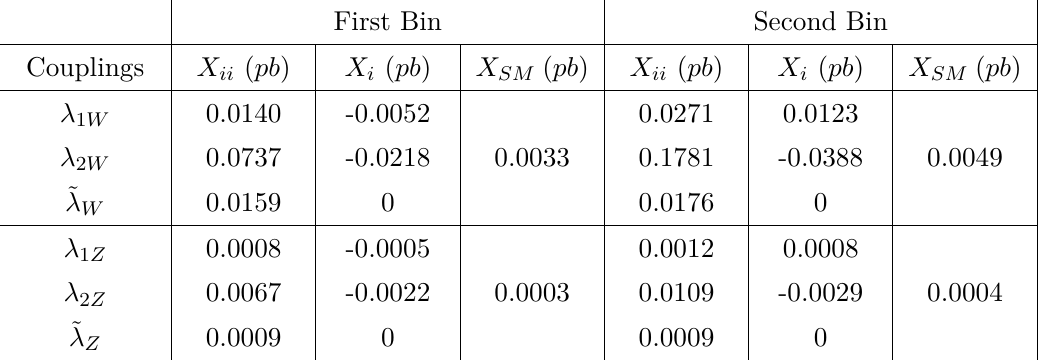
Table 3 . Coefficients of BSM parameters given in eq. 2.1 for ∆ φ distribution after applying all